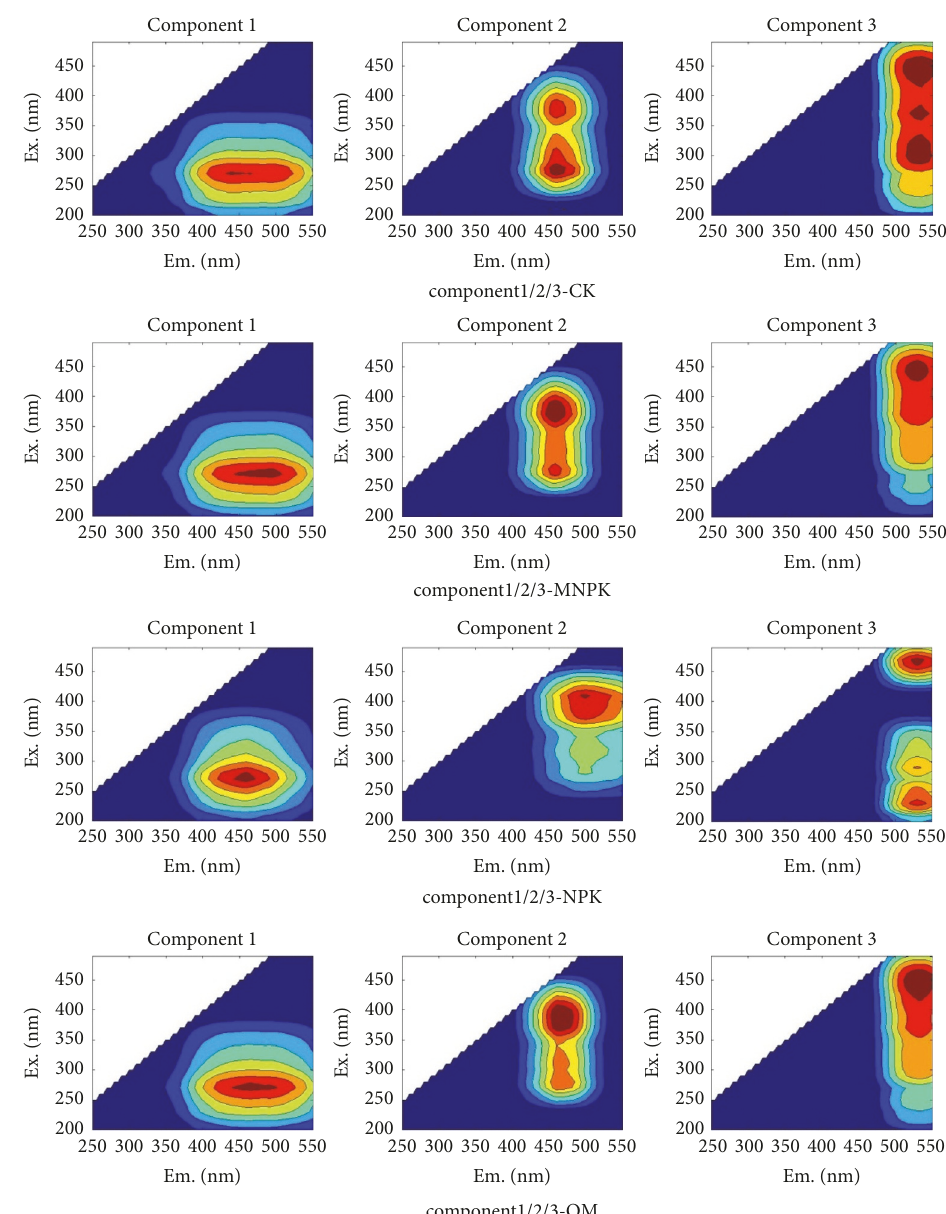
Figure 1: Fluorescence components C1, C2, and C3 after different fertilization treatments (CK=control, NPK= NPK fertilizer, OM=organic manure, and MNPK=manure + NPK fertilizer) identified by